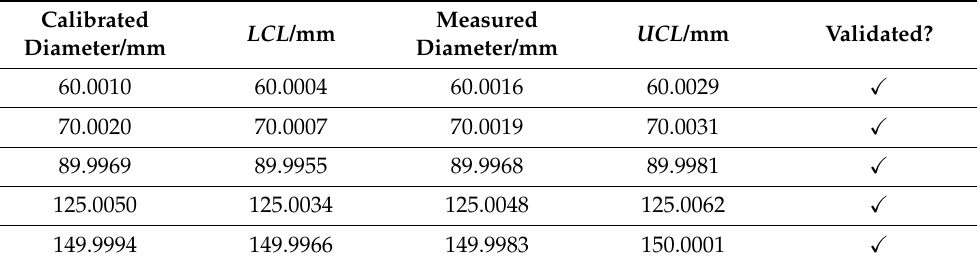
Table 6. The second validation test with calibrated diameter, measured results and the estimated confidence